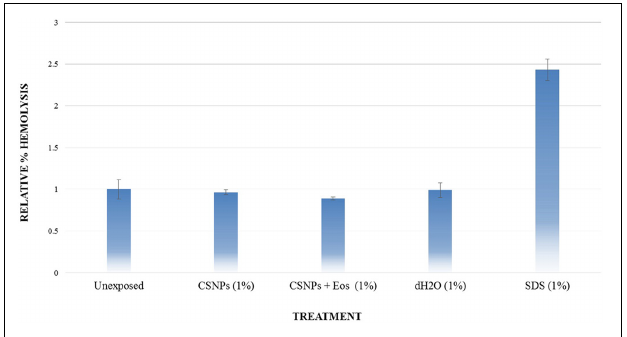
FIGURE 5 | Hemolysis analysis. Evaluation of % hemolysis induced by chitosan NP and cardamom oil-loaded CSNPs. It can be observed that both empty and EOs-loaded CSNPs are not causing hemolysis.